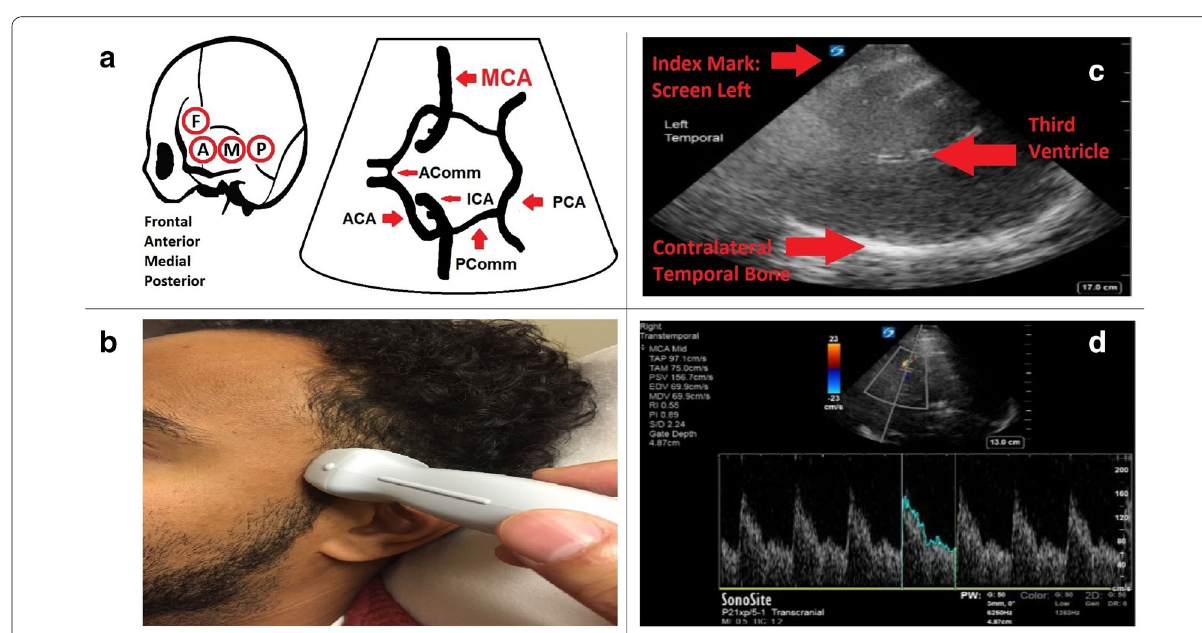
Fig. 5 Method for acquisition of transcranial Doppler. a Left side shows location of the trans-temporal window and its various sections: frontal, anterior, medial, and posterior. Right side illustrates Circle of Willis, with MCA highlighted. b Probe index mark orientation towards the patient’s anterior/front. c Typical 2D image of TCD from trans-temporal window with index mark to screen left, with bright echogenic contralateral temporal bone, and anechoic space of midline third ventricle. d Typical spectral Doppler velocity waveform from MCA, with steep systolic upstroke and step- down diastolic flow (typical mean velocity of 80 cm/s)